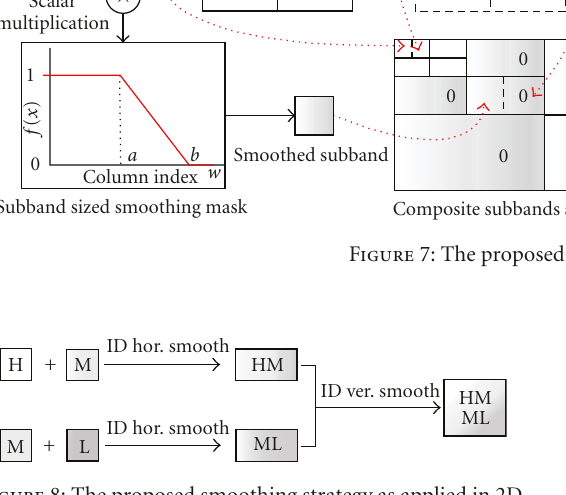
(ii) The highest 3 l h subbands of center tile (H) and 3 l m subbands of its 4-neighbors (labeled M) are stu ff ed with 0s. (iii) Last are the remaining 3( l l − l h ) and 3( l l − l m ) subbands of central tile and its 4-neighbors,